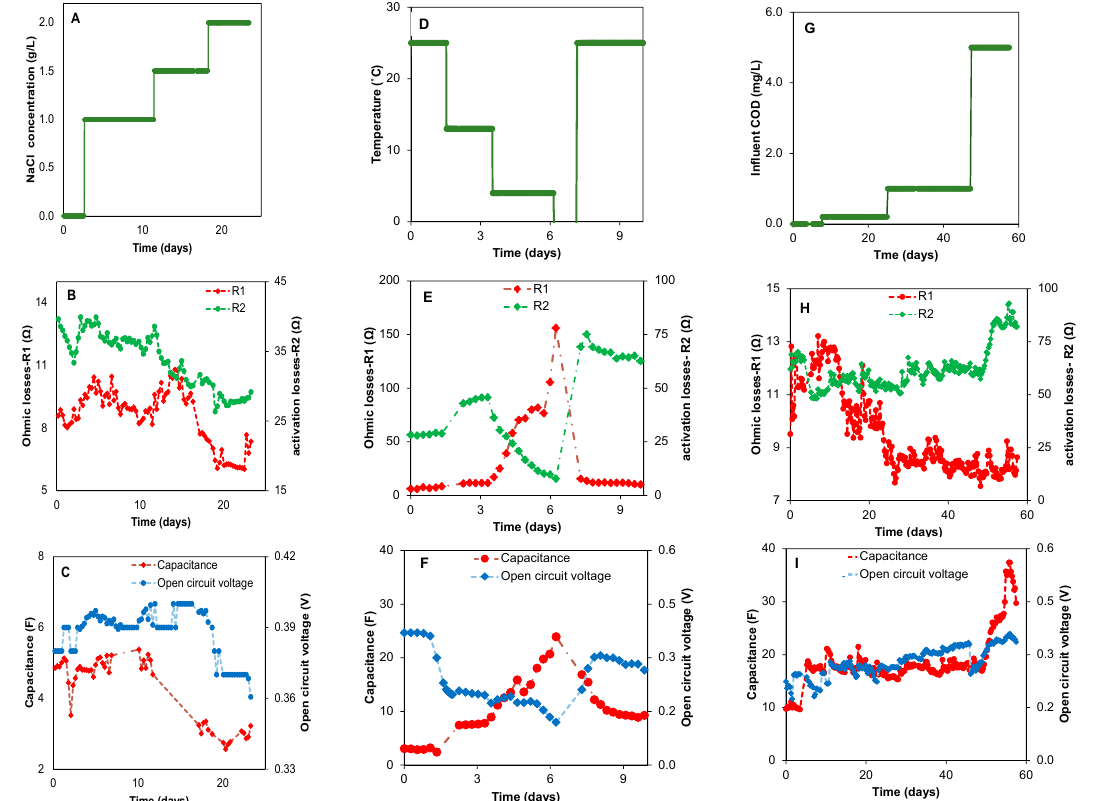
Figure 5. Results of real-time monitoring of 3D biobattery internal parameters. ( A ) Changes in salt content of anodic liquid and ( B , C ) resulting changes in internal resistance, capacitance, and OCV; ( D ) Temperature changes and ( E , F ) resulting changes in internal resistance, capacitance, and OCV; ( G ) Changes of soluble COD concentration and ( H , I ) resulting changes in internal resistance, capacitance, and OCV. Between days 6.2–7.3 of the temperature test the biobattery was accidentally frozen (no measurements).